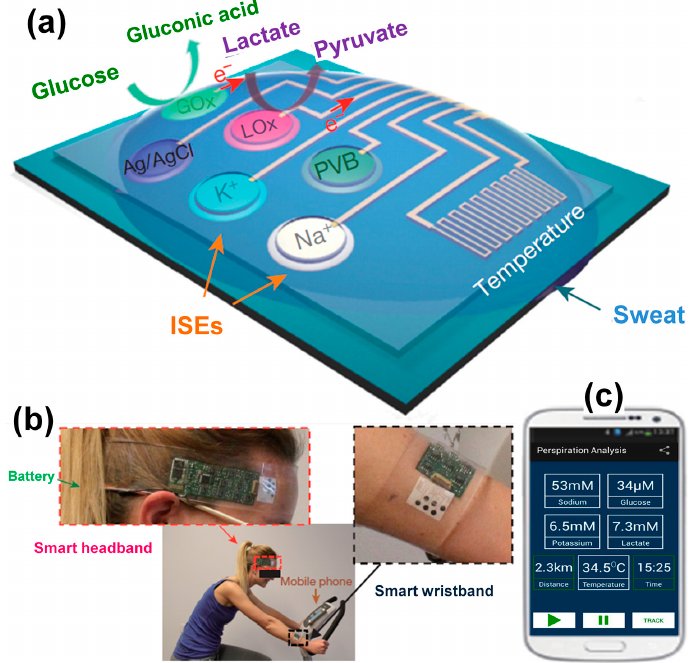
Figure 2. ( a ) Schematic illustration of the sensor array (including glucose, lactate, sodium, potassium and temperature sensors) for multiplexed perspiration analysis including: ion-selective electrodes (ISEs), polyvinyl butyral (PVB), glucose oxidase (GOx) and lactate oxidase (LOx); ( b ) Photographs of a subject wearing a “smart headband” and a “smart wristband” during stationary cycling; ( c ) Real ‐ time data display of sweat analyte levels as well as skin temperature during exercise. Reprinted and Adapted with permission from Reference [3]. Copyright Macmillan Publishers Limited, 2016.